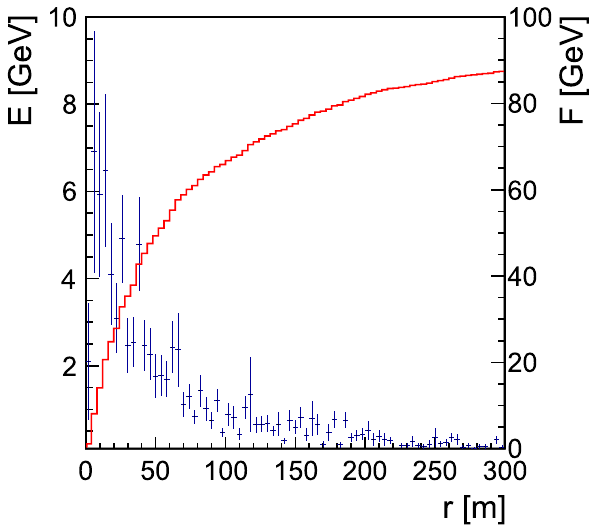
Fig. 1 The energy distribution at the ground for one event with S em = 96 . 5 GeV, E 0 = 1165 . 9 GeV and X max = 334 gcm − 2 . Also shown the respective cumulative function F ( r